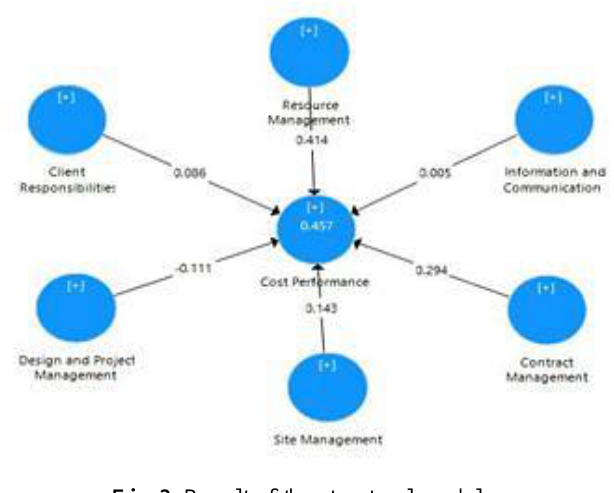
Fig. 3. Result of the structural model